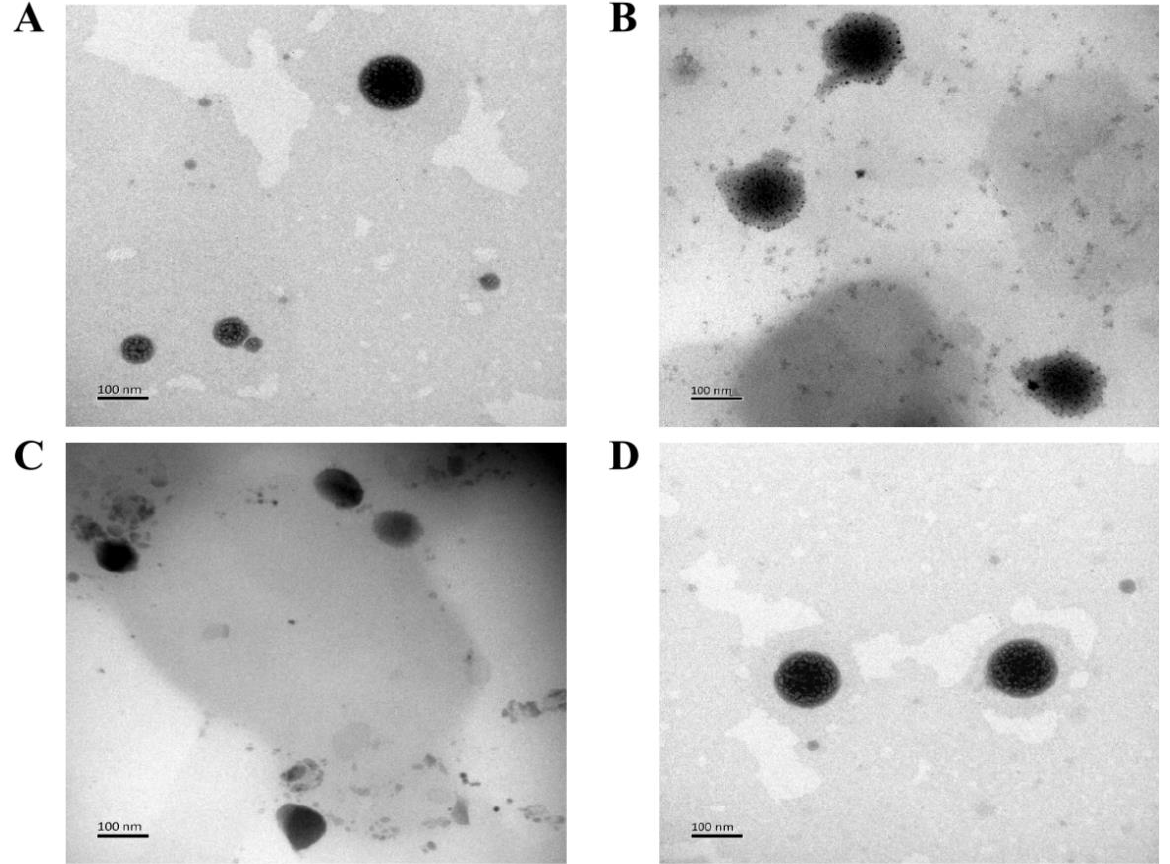
Figure 3. Transmission electron micrograph ( A ) CSLNs; ( B ) GA-CSLNs; ( C ) FA-CSLNs; and ( D ) GA-FA-CSLNs. Table 1. Characteristics of CSLNs (x ± s, n = 3).